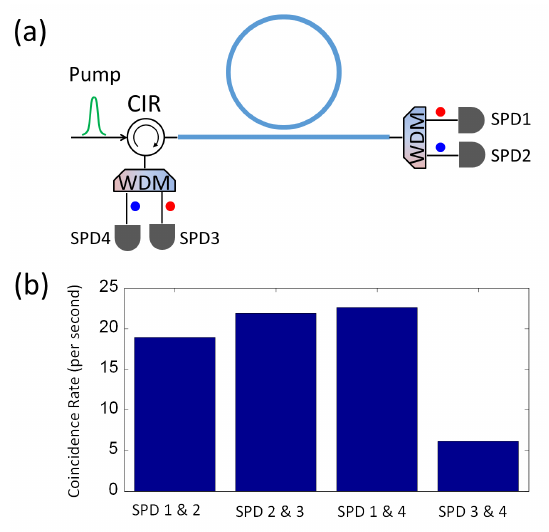
Fig. 5. (a) Experimental setup for measuring the backscattering effect on photon generation. CIR, circulator; WDM, wavelength division multiplexer. (b) The measured coincidence distribution between forward and backward propagating